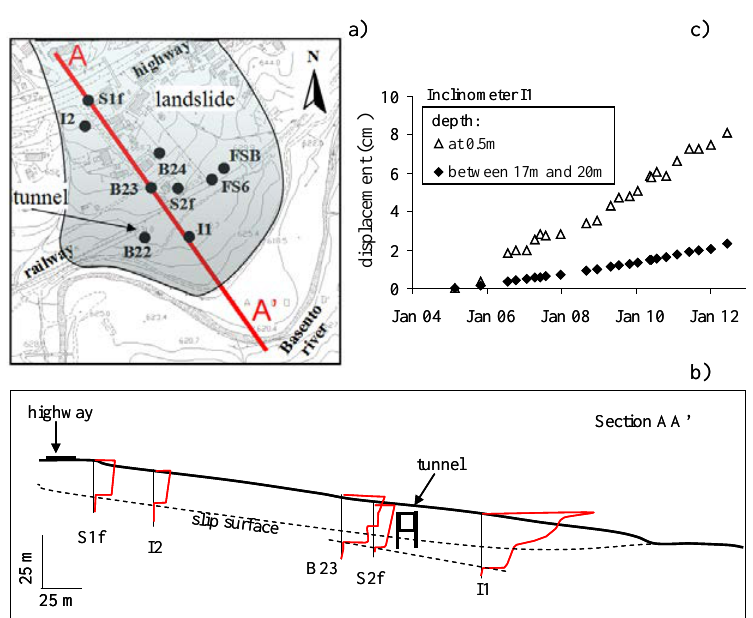
Figure 2. Map of the study area ( a ); section AA’ with inclinometer profiles ( b ); displacements measured by the inclinometer I1 against time ( c ).